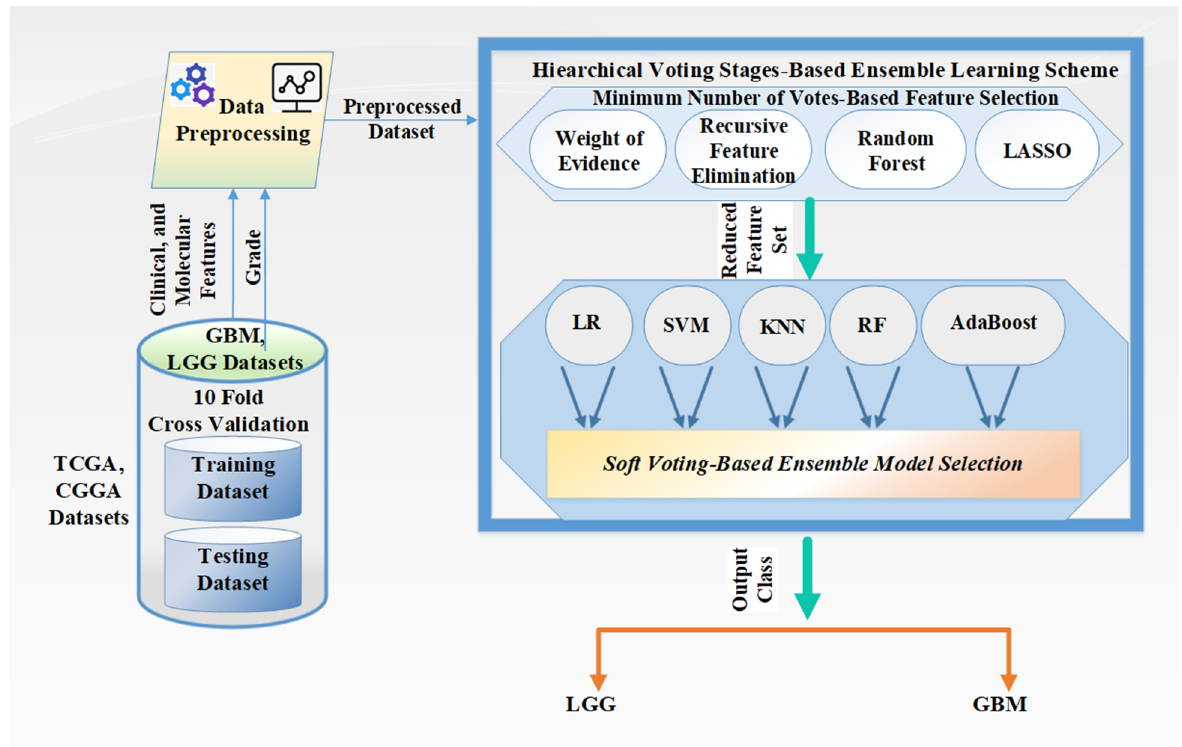
Figure 3. Overview of the proposed methodology.